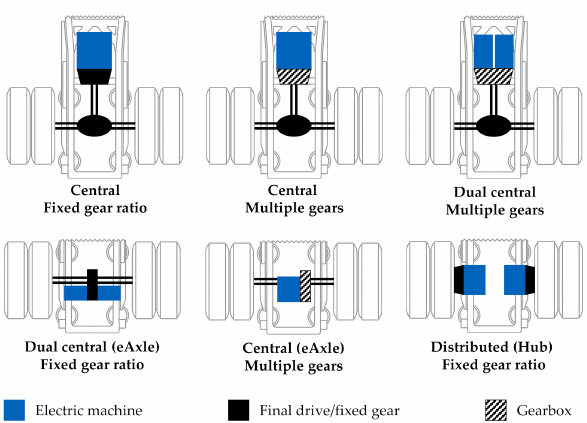
Figure 1. Topologies for electric drive axles for heavy-duty